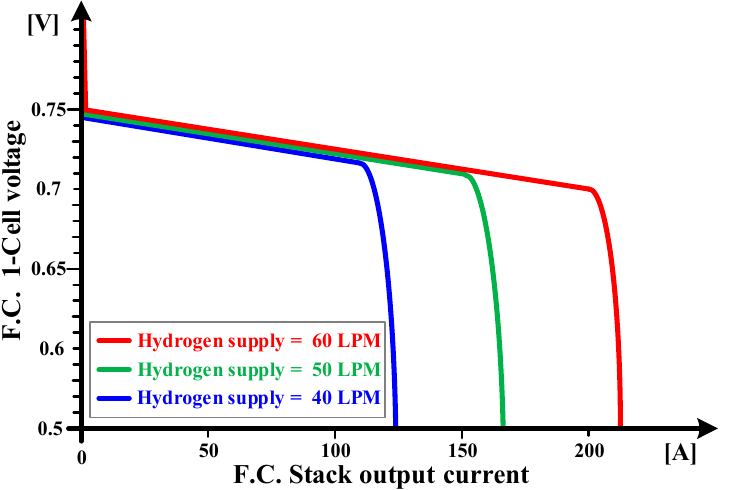
Figure 4. Voltage characteristic curve depending on the amount of hydrogen supply.